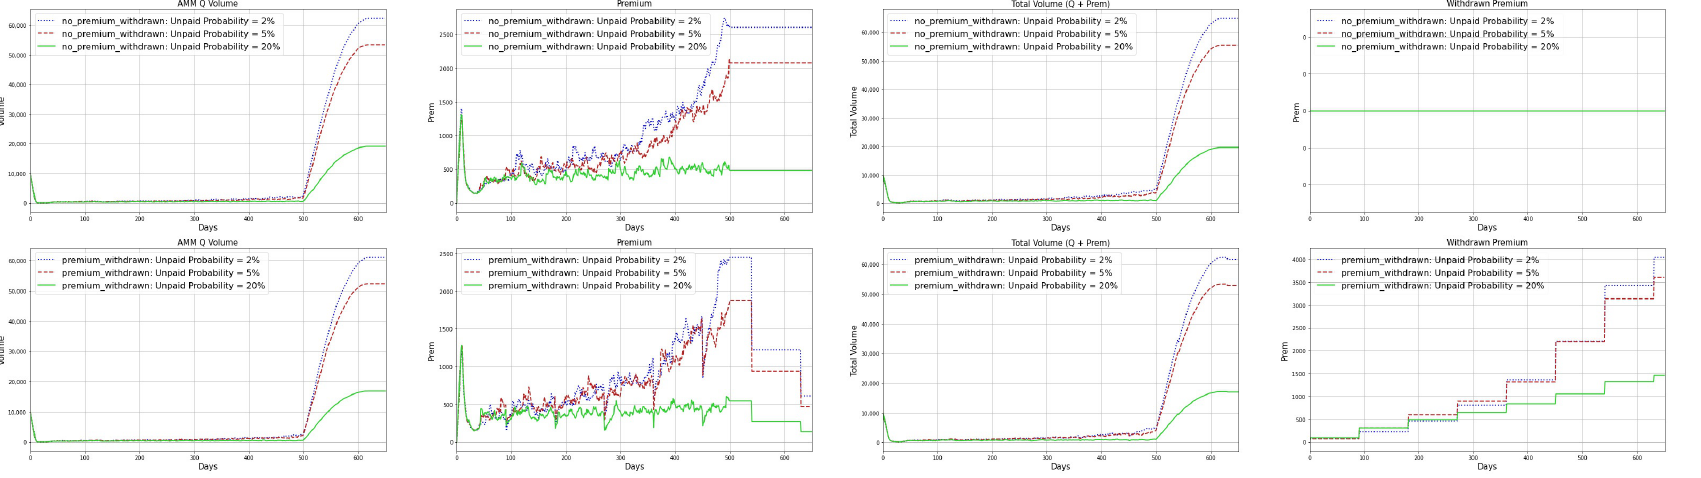
Figure A6. rkAMM Curves from simulation of scenario 2 and 90 days of withdrawal